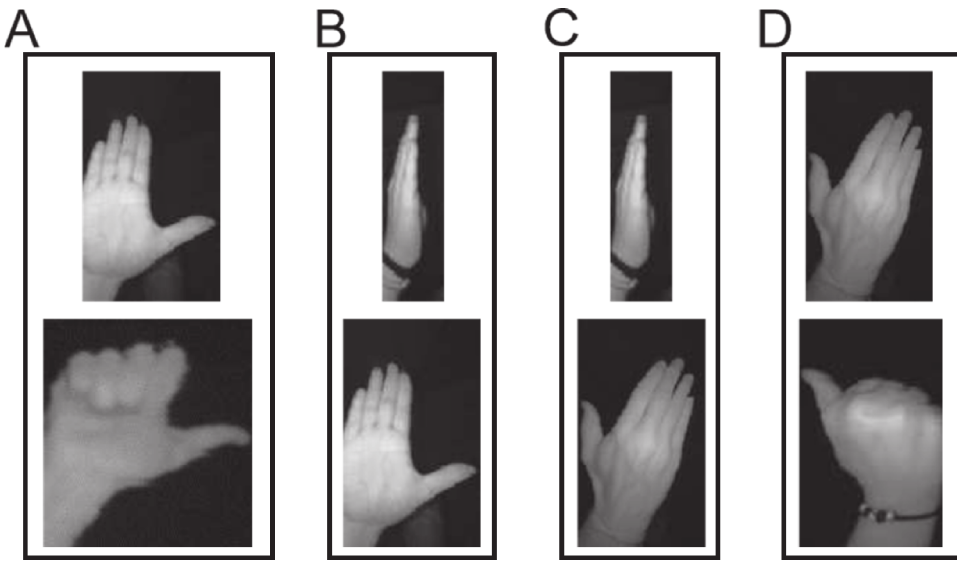
Fig 9. Dynamic hand gestures of the dataset. (A) go down, (B) go left, (C) go right, (D) go